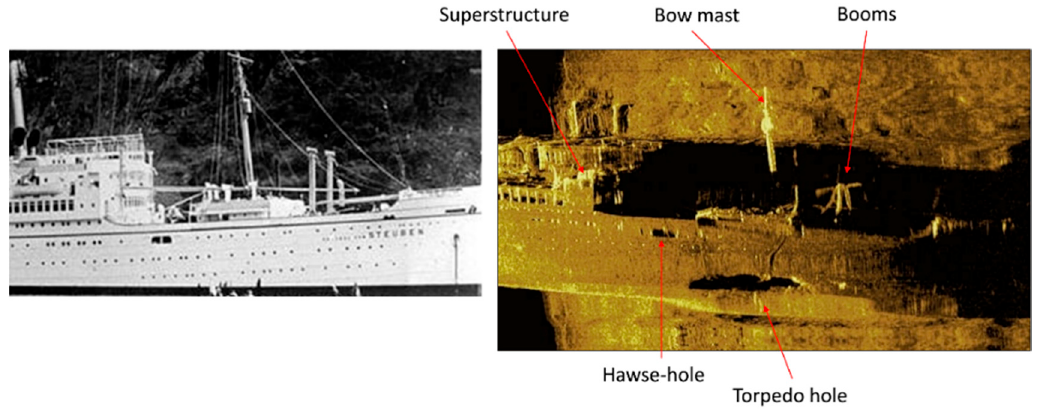
Figure 14. Comparison of the recorded sonar data with the photographic documentation of the bow part of the Steuben ship.